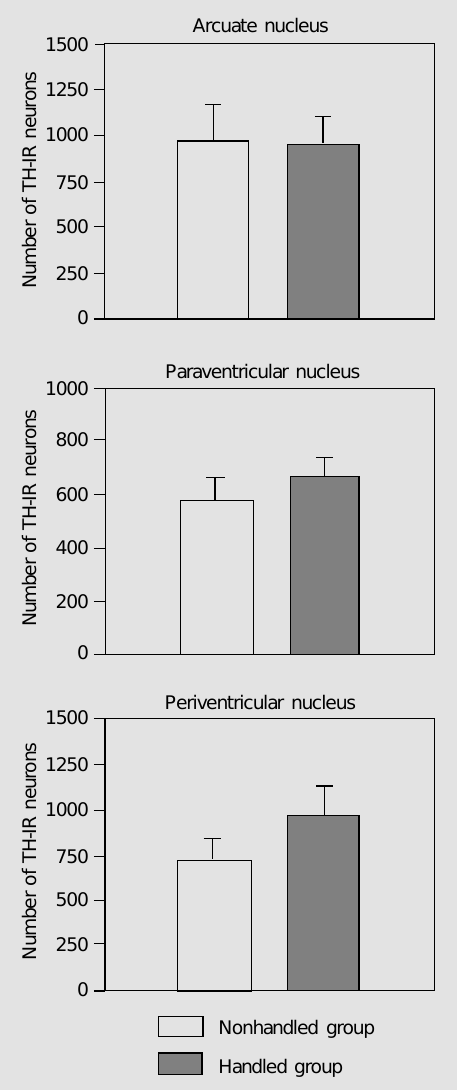
Figure 1. Effect of neonatal han- dling (1 min per day) during the first 10 days of life on the num- ber of neurons immunoreactive to tyrosine hydroxylase (TH-IR) in the arcuate (N = 6 in each group), paraventricular (N = 8 in the nonhandled group and N = 9 in the handled group) and peri- ventricular (N = 7 in each group) nuclei of the hypothalamus of adult (75-80 days old) male rats. Each bar represents the mean ± SEM of the estimated total num- ber of TH-IR neurons in bilateral